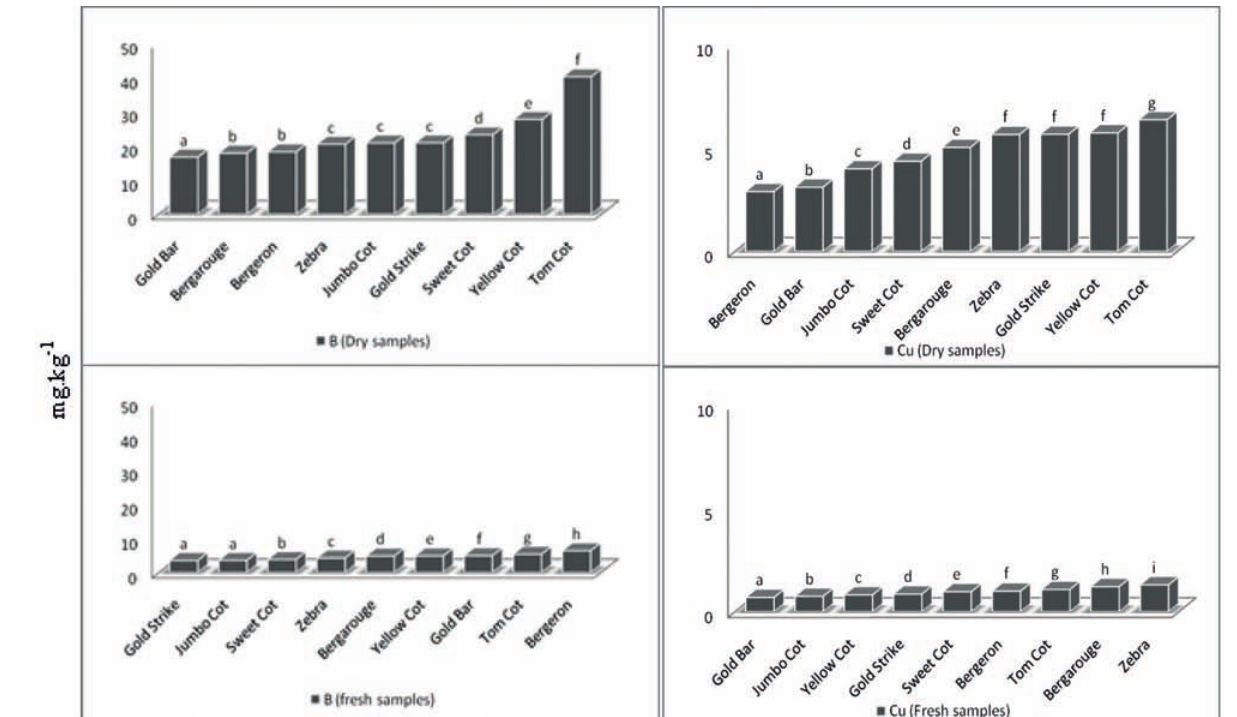
Figure 1. Concentration of Boron in apricot cultivars (mgkg-1), columns with different caption have a significant difference (P